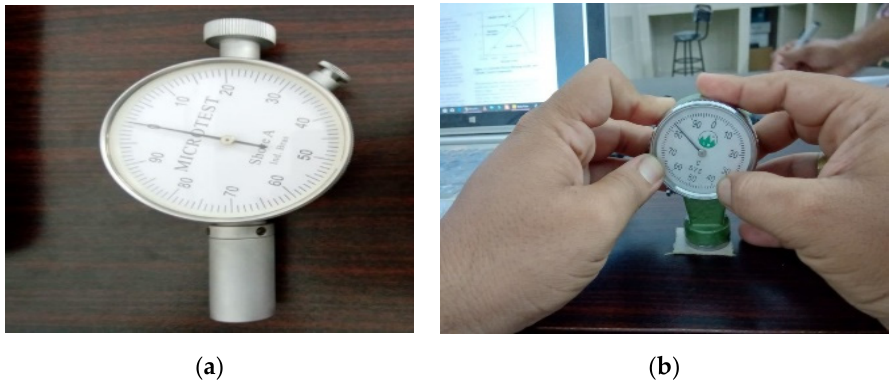
Figure 3. Shore A ( a ) and Shore C hardness ( b ) tester, respectively.